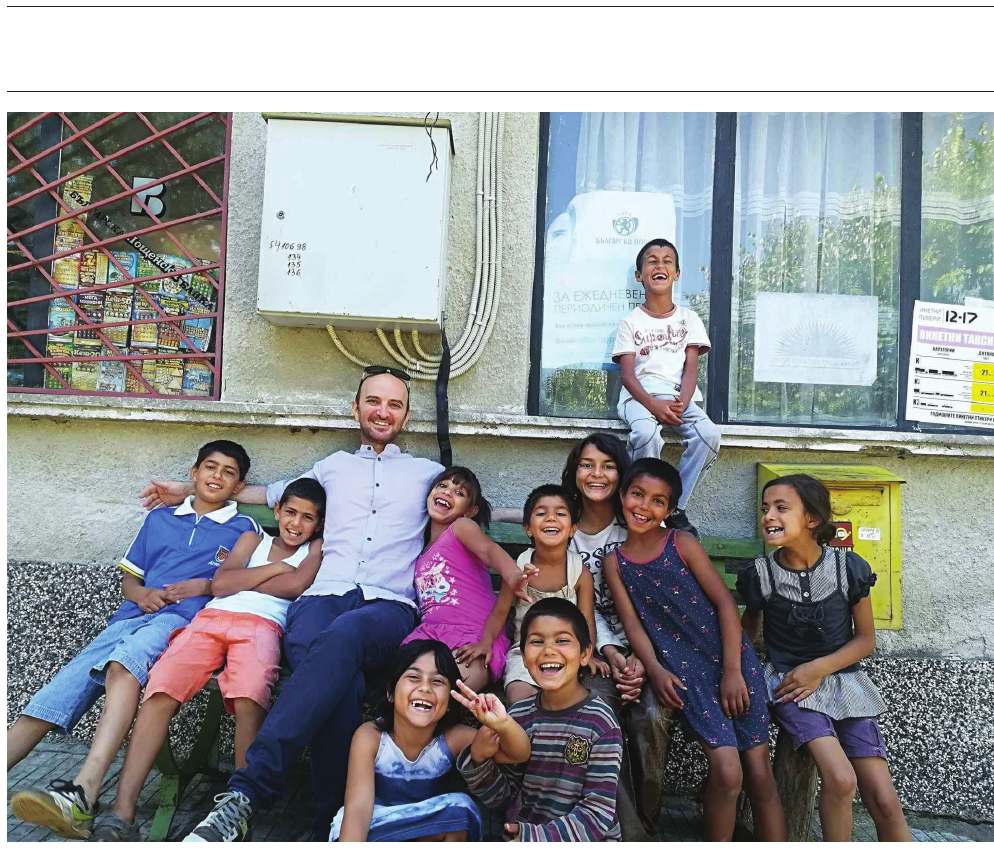
Figure 2: After the screening of Back to School in the village of